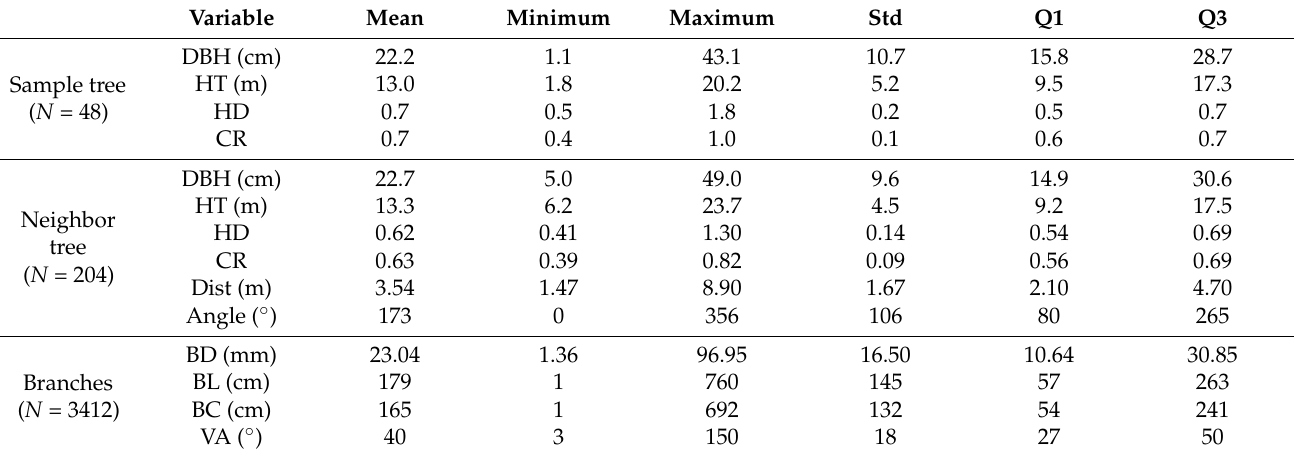
Table 2. The descriptive statistics of the tree attribute variables for the sample trees, nearest neighbor trees, and the branches. HT is total tree height, HD is the ratio of HT and DBH, CR is the crown ratio, and Q1 and Q3 are the 25% and 75% quantiles,